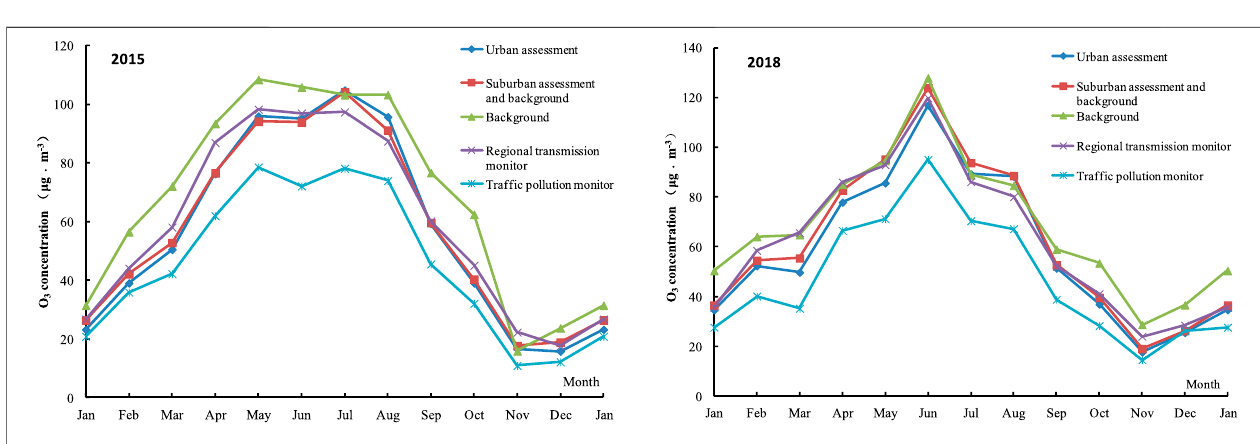
FIGURE 8 | Monthly averaged O 3 concentrations for the different types in 2015 and